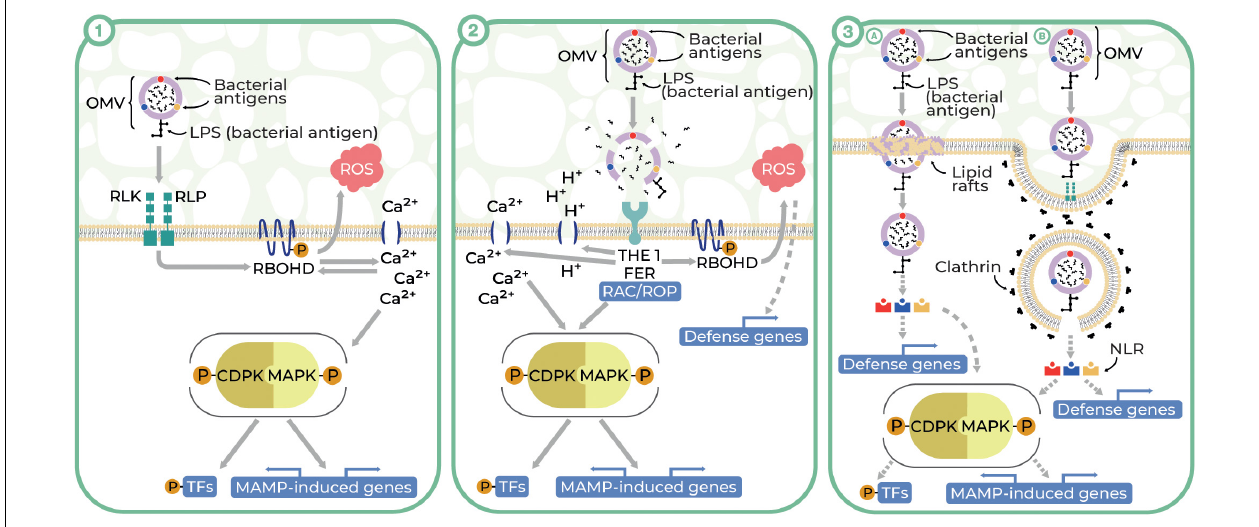
FIGURE 1 | Three theoretical pathways of plant–OMV interactions (Illustrator: Maraszewska Małgorzata). (1) OMVs enter plant cells after recognition of OMV-associated MAMPs by RLKs and RLPs (PRRs) and activate PTI. The binding of MAMPs to PRRs results in their dimerization. The intracellular domain of PRR dimers phosphorylates RBOHD, leading to ROS bursts and rapid Ca 2 + ion-flux. An increase in Ca 2 + concentration activates CDPK and MAPK and co-regulates the activity of RBOHD. Activation of MAPKs and CDPKs induces cascades of immune signaling by phosphorylation, resulting the activation of transcription factors (TFs) in the nucleus and regulating gene expression. (2) OMVs lyse and release the cargo due to the acidic environment of the plant apoplast. Hydrolases released from OMV disturb CWI. CWI is controlled by plasma membrane-localized receptor-like kinases THE1 and FER. FER acts as a cell surface regulator for ROP/RAC GTPases responsible for activating RBOHD, ROS burst, changes in cytosolic pH and Ca 2 + concentration, and also CDPK and MAPK activity. (3) OMVs may enter into the plant cells by the clathrin-independent pathway through lipid rafts (A) or clathrin-dependent endocytosis (B). The latter route begins with invagination of clathrin-coated pits (CCPs) with simultaneous recruitment of conserved adaptor protein complex 2. Mature clathrin-coated vesicles (CCVs) detach from the plasma membrane and move into the cytosol with the involvement of the cytoskeleton. The last stage of endocytosis is the uncoating and release of CCV cargo to the cytoplasm or transporting the CCV to the early endosome, where the fate of CCV is determined. In both pathways, the OMV cargo, being recognized by cytoplasmic receptors NLR (nucleotide-binding, leucine-rich repeat receptor), may activate MAMP-induced defense components (RBOHD, ROS burst, MAPKs, and CDPKs) or changes in defense genes’